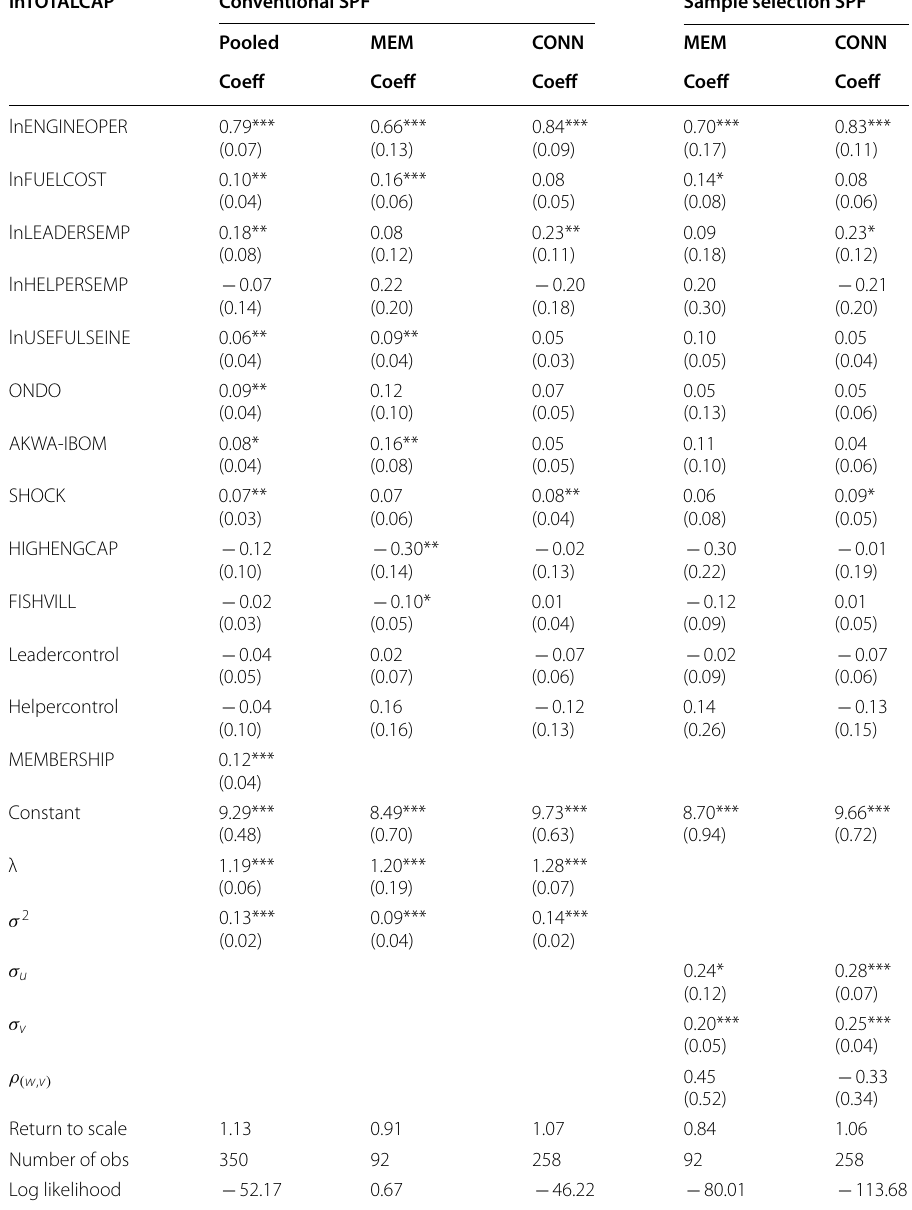
Table 5 Parameter estimates for conventional and selectivity SPF models: Matched